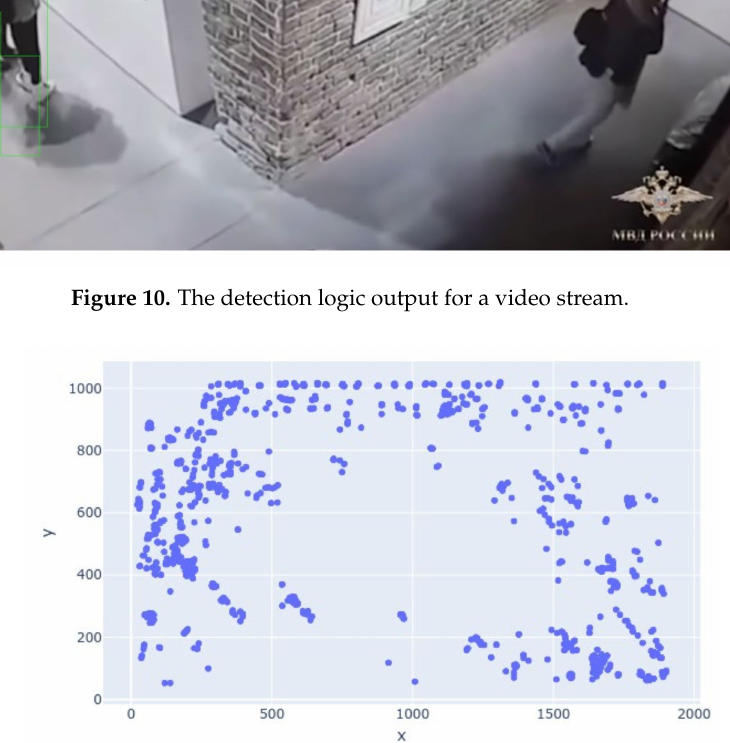
Figure 11. The detection logic output for a video